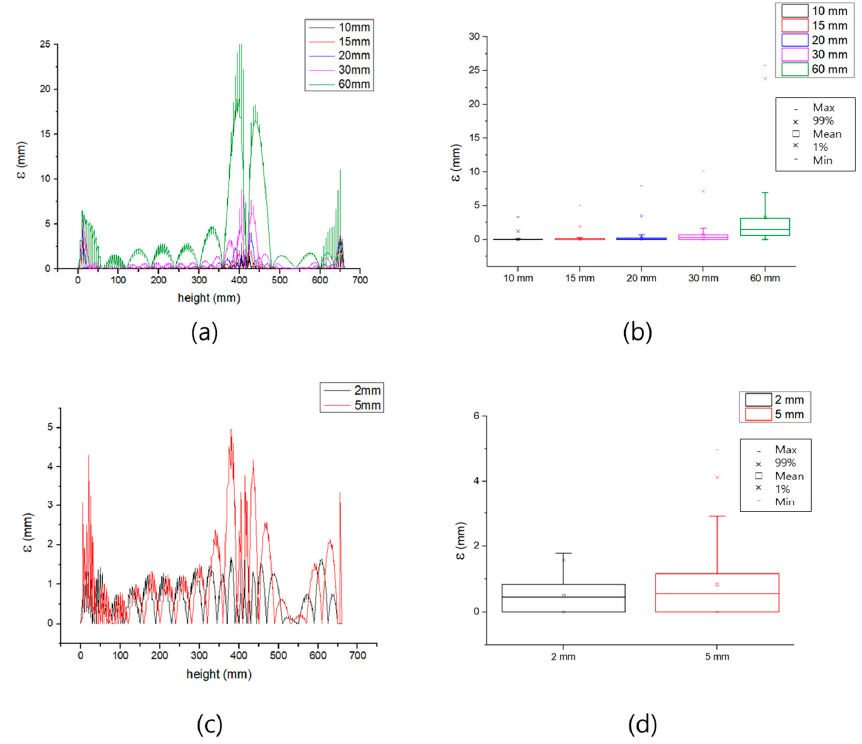
Figure 5. Graphs of the simulation results; ( a ) surface error of uniform slicing with respect to the height; ( b ) box chart of surface error of the uniform slicing; ( c ) surface error of the adaptive slicing with spec to the height; ( d ) box chart of surface error of the adaptive slicing.